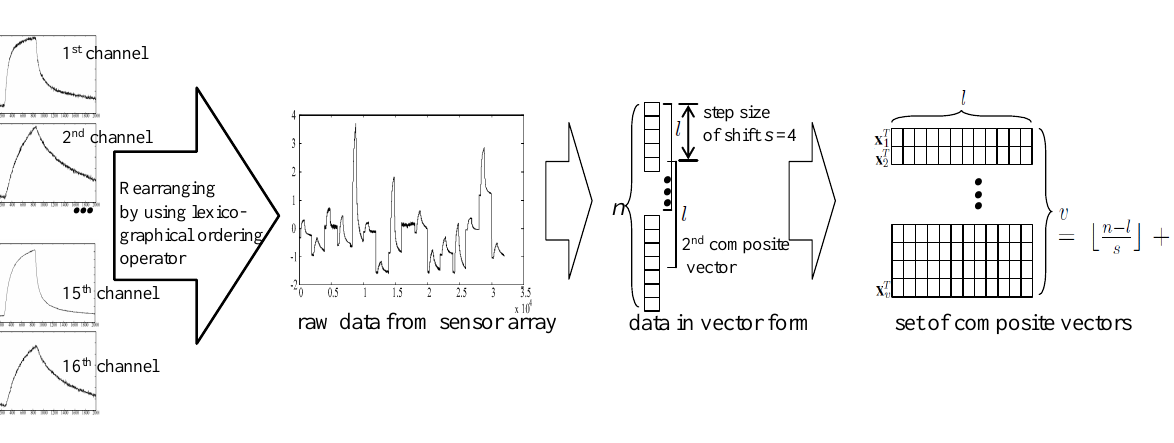
Figure 2. Constructing composite